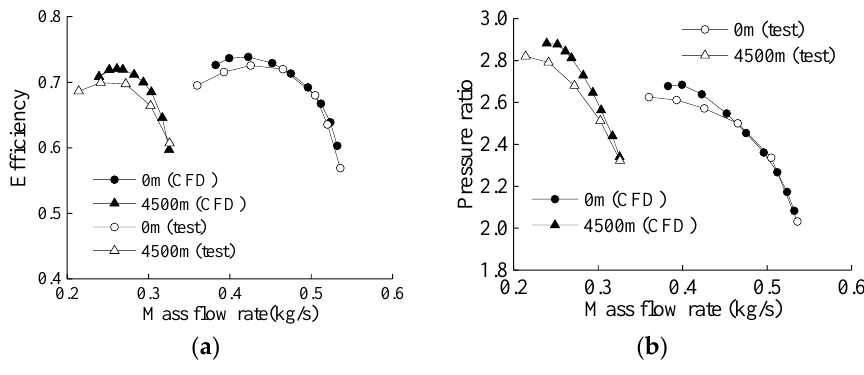
Figure 4. Change of compressor performances: ( a ) Efficiency characteristics; ( b ) Pressure ratio characteristics.